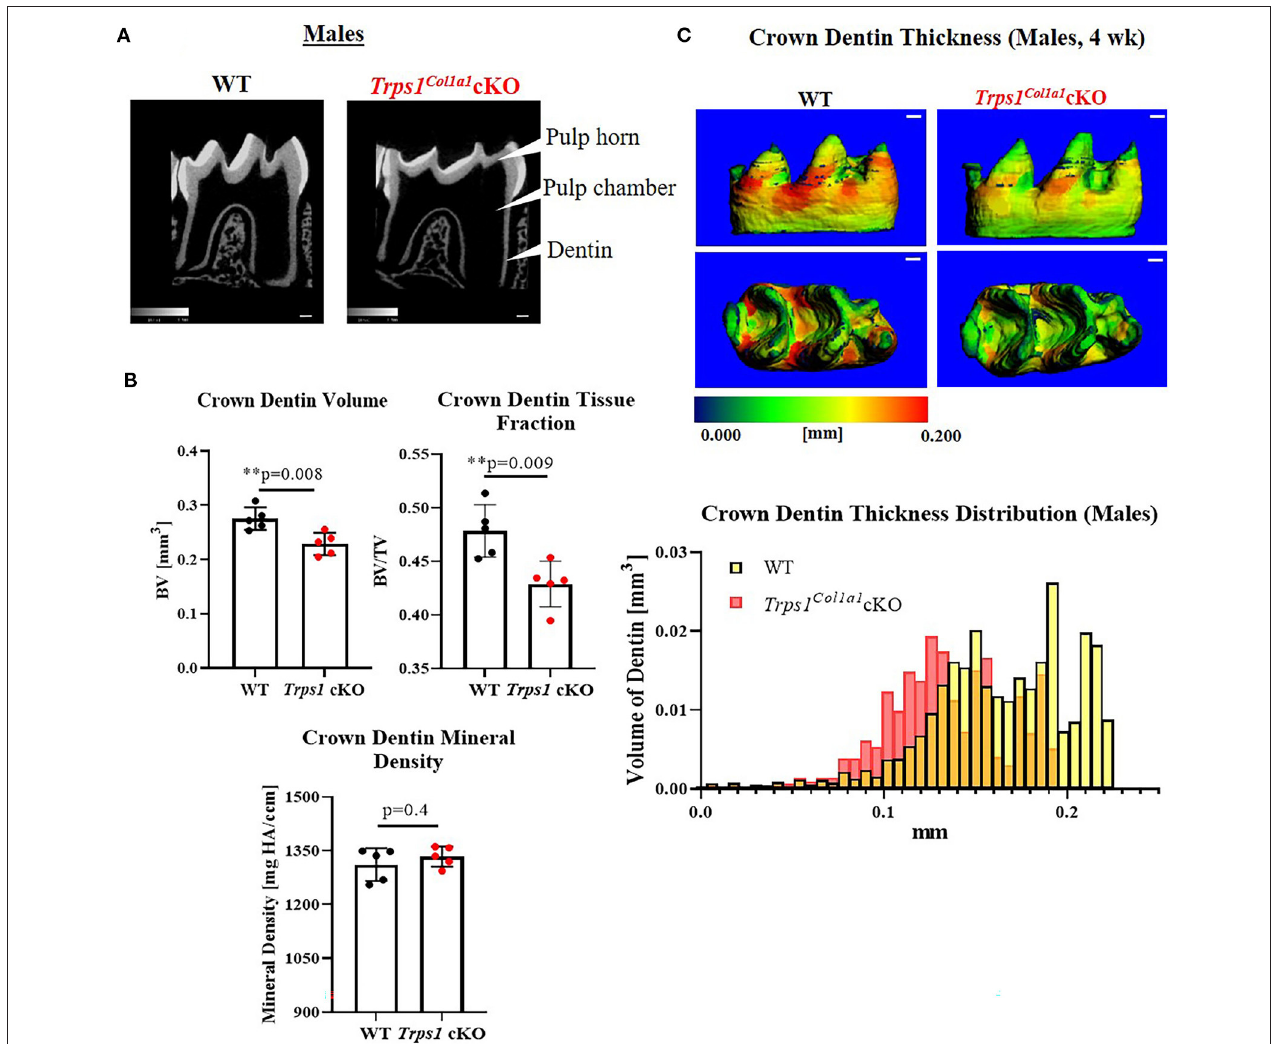
FIGURE 4 | Quantitative µ CT analyses of crown dentin of mandibular first molars of 4 wk old WT and Trps1 Col1a1 cKO males. (A) Representative 2D µ CT images showing reduced dentin thickness (white arrowheads) and enlarged pulp chambers in Trps1 Col1a1 cKO males compared to WT. (B) Quantification of crown dentin volume, dentin tissue fraction in the total crown volume and mineral density. Mean values ± SD and individual data points (dots, N = 5/genotype) are shown; ** p < 0.01. (C) Representative 3D µ CT images of the crown dentin; scale bar = 100 µ m. The dentin was pseudo-colored based on the distribution of tissue thickness. The corresponding tissue thickness color scale is shown below the images. Note thinner dentin at the lingual and occlusal surface in Trps1 Col1a1 cKO males vs. WT. The graph below the 3D images shows the comparison of the quantity (volume) of the crown dentin with specific thickness in WT and Trps1 Col1a1 cKO